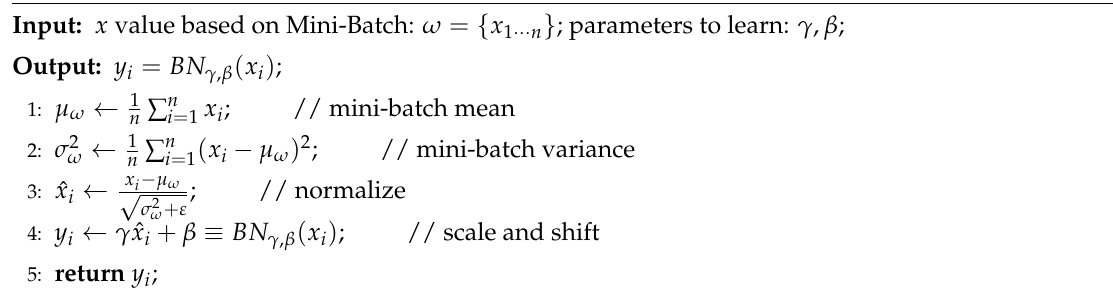
Algorithm 2 Batch Normalization (based on